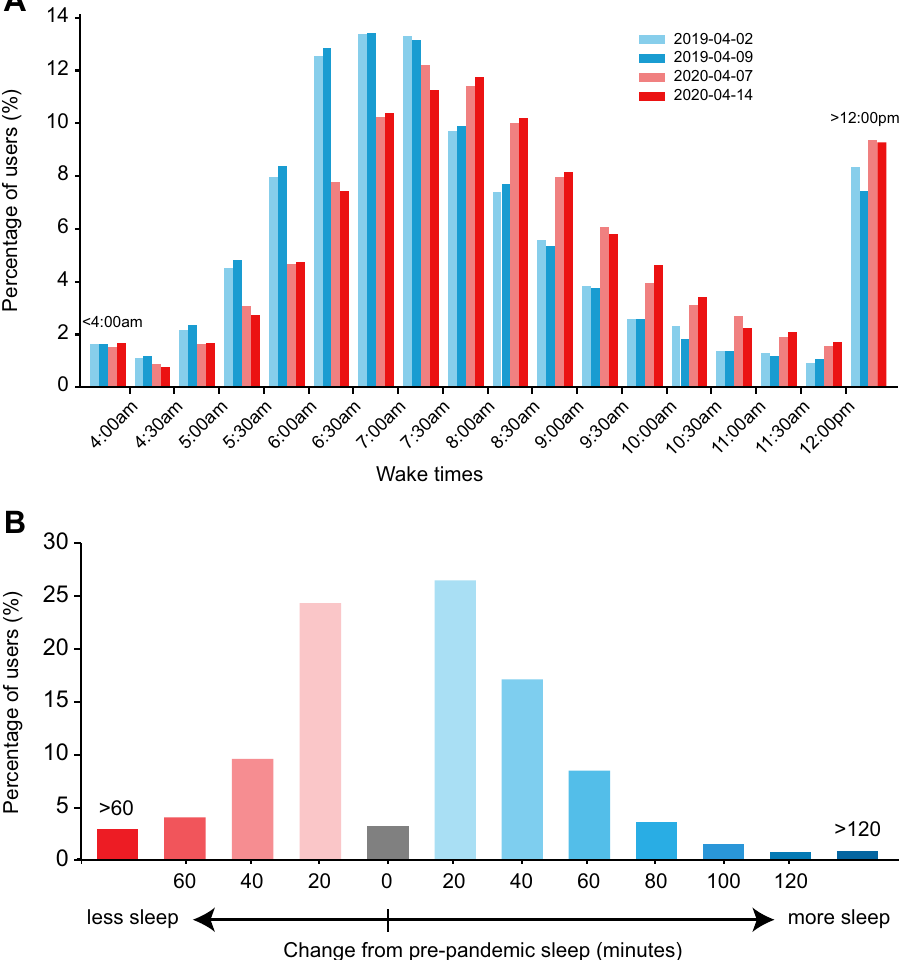
Figure 5. Overall effect of the pandemic on weekday waketimes and sleep duration. ( a ) Self-reported waketimes from the first two Tuesdays in April 2019 and 2020 are indicated in blue and red respectively, from users around the world. ( b ) Change in weekday hours slept during the pandemic in a subset of 12,551 individuals with data from both 2019 and 2020. No change (gray bar) was defined as < 1 min change from pre- pandemic sleep. Increases are indicated in blue and decreases are indicated in